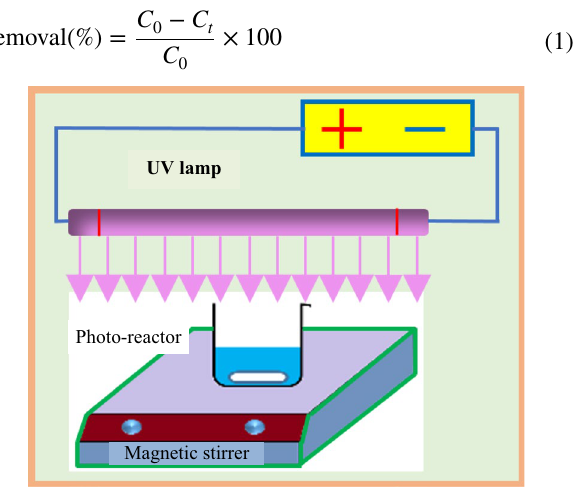
Fig. 1 Schematic diagram of batch photoreactor